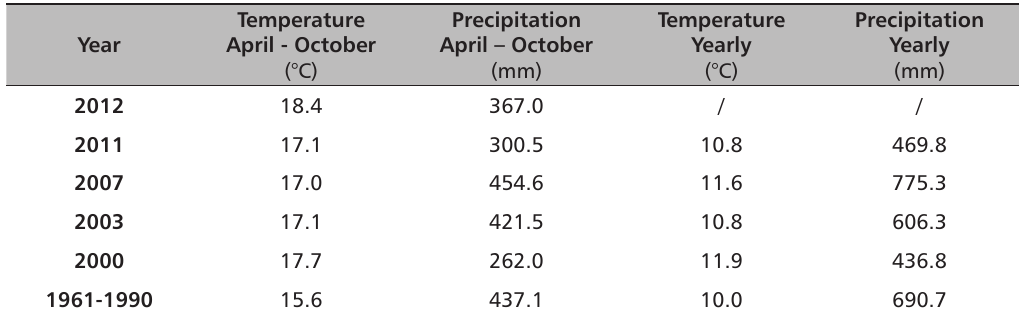
TABLE 1. Climate conditions in Serbia for several extremely dry years